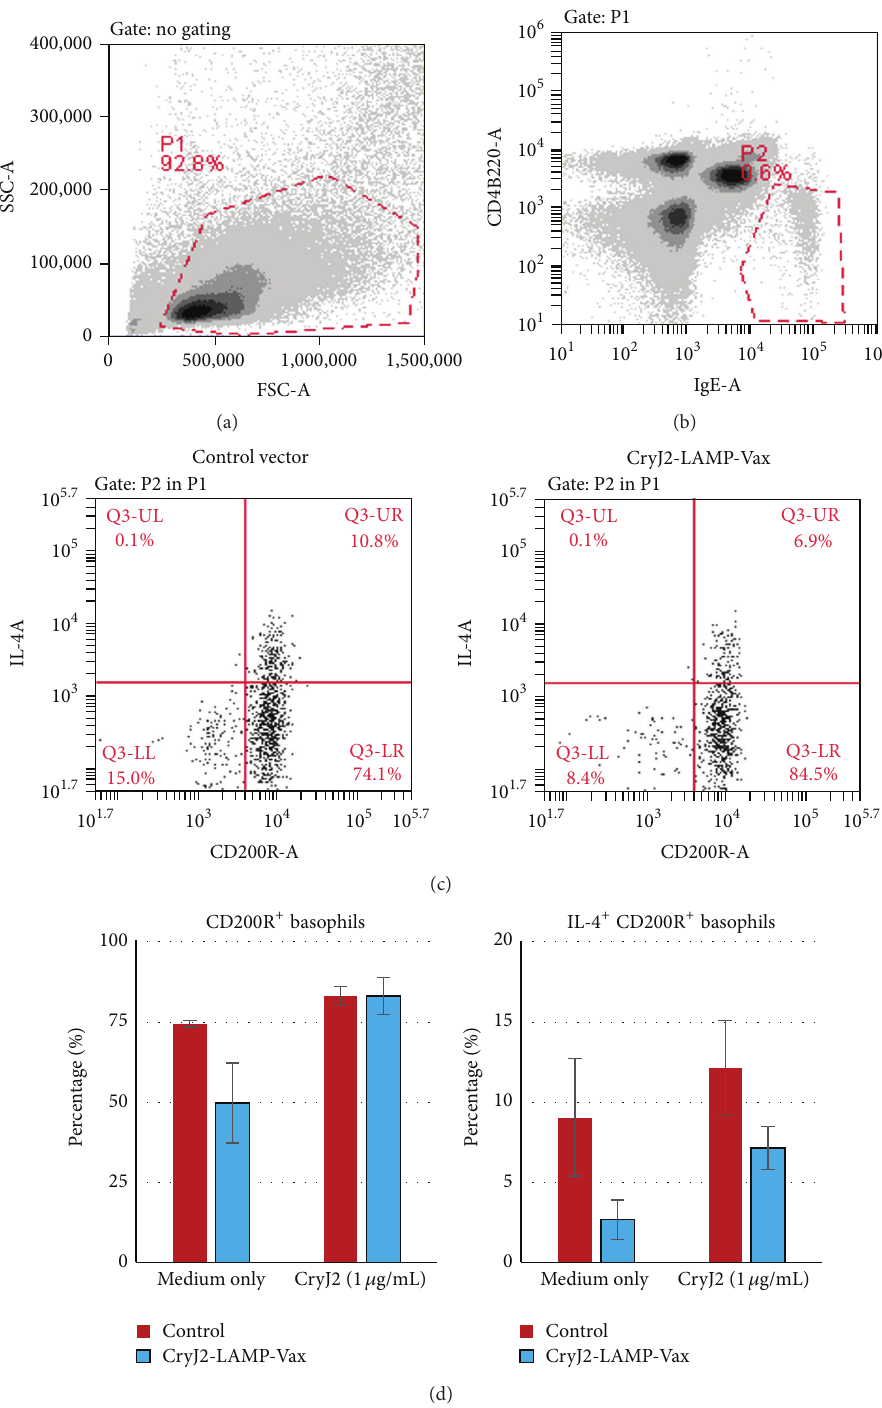
Figure 4: CryJ2-LAMP vaccination affects IL-4 production by basophils. Two groups of mice ( 𝑛 = 6 ) were immunized with 50 𝜇 g CryJ2- LAMP plasmid or a control vector by Biojector injection on days 0, 7, and 14. Mice were boosted with 5 𝜇 g CryJ2 on day 42. On day 77, peripheral blood was assayed for basophils activation and IL-4 production. (a) Cells are gated by size. (b) IgE + CD4 − B220 − cells are defined as basophils. (c) Expression of IL-4 and CD200R in IgE + CD4 − B220 − cells from two representative samples from control ( left ) or CryJ2-LAMP ( right ) group is shown. (d) Analysis of percentages of CD200R + /IgE + CD4 − B220 − cells ( left ) and IL-4 + /CD200R + IgE + CD4 − B220 − cells ( right ) is shown. All data are shown as mean ±